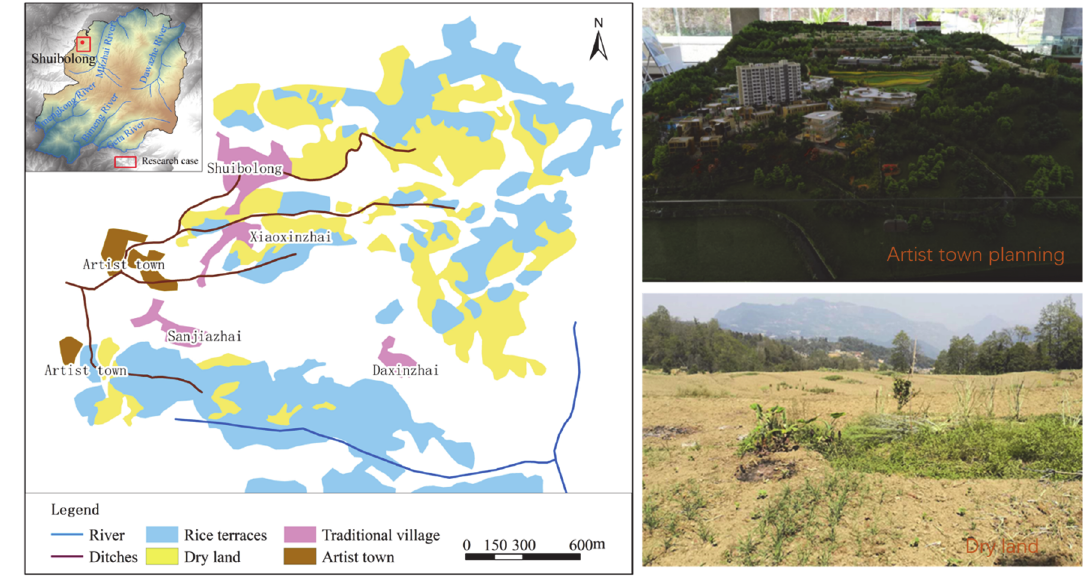
Figure 4. The locations of Artist town and the dry